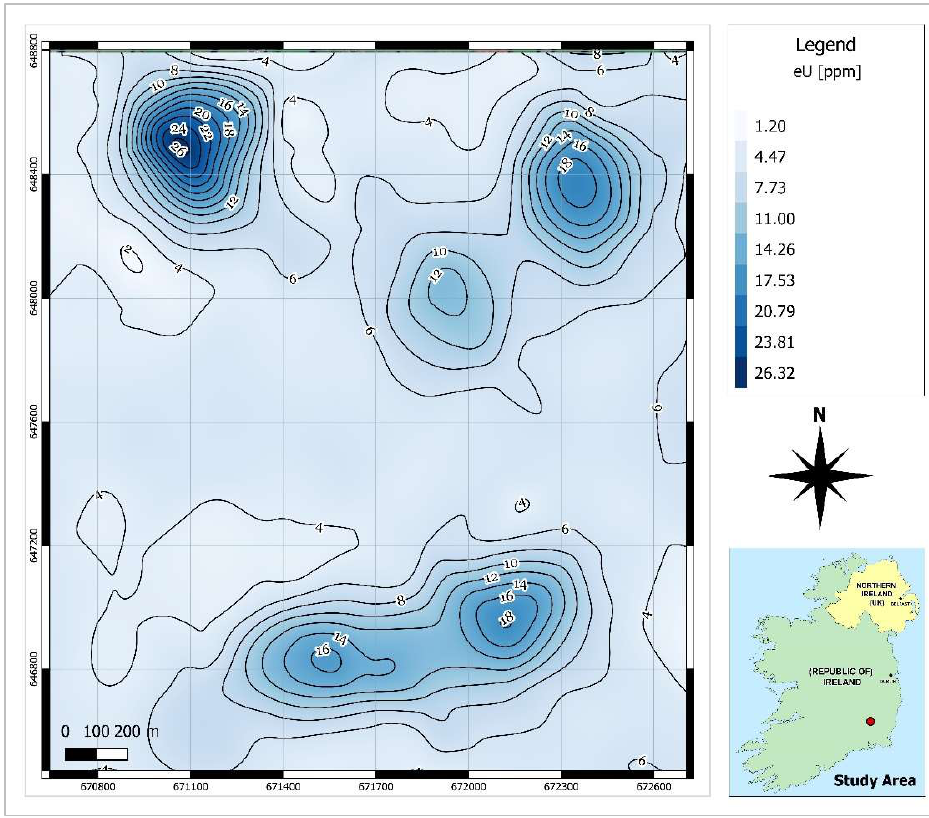
Figure 3. Contour map of equivalent uranium concentration (eU).